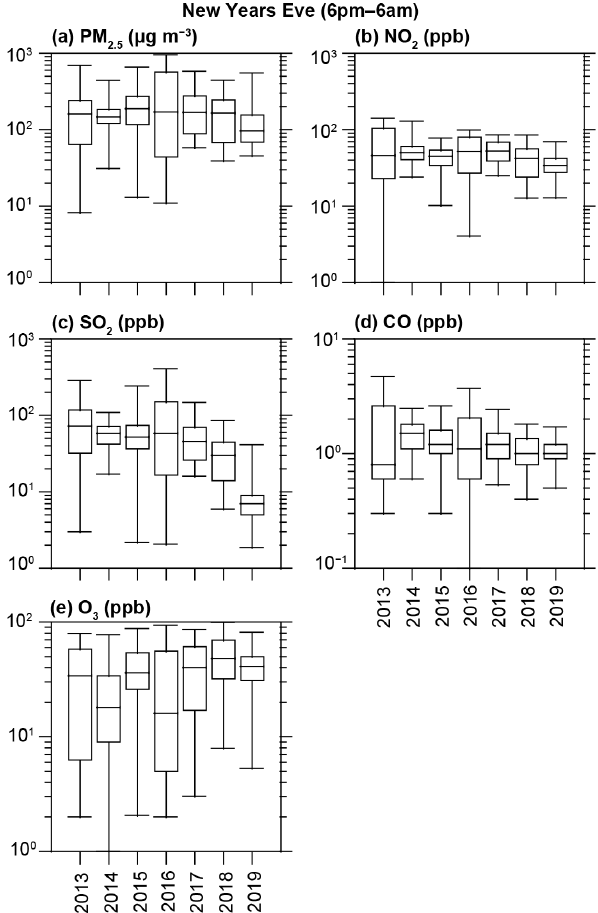
Figure 9. Boxplots of PM 2 . 5 and trace gases between 18:00 and 06:00 on the night of the Chinese New Year in the years 2013– 2019. The boxplots show 1st, 25th, 50th, 75th, and 99th percentiles of the data across the 12 sites during this 12h period (13 time points,